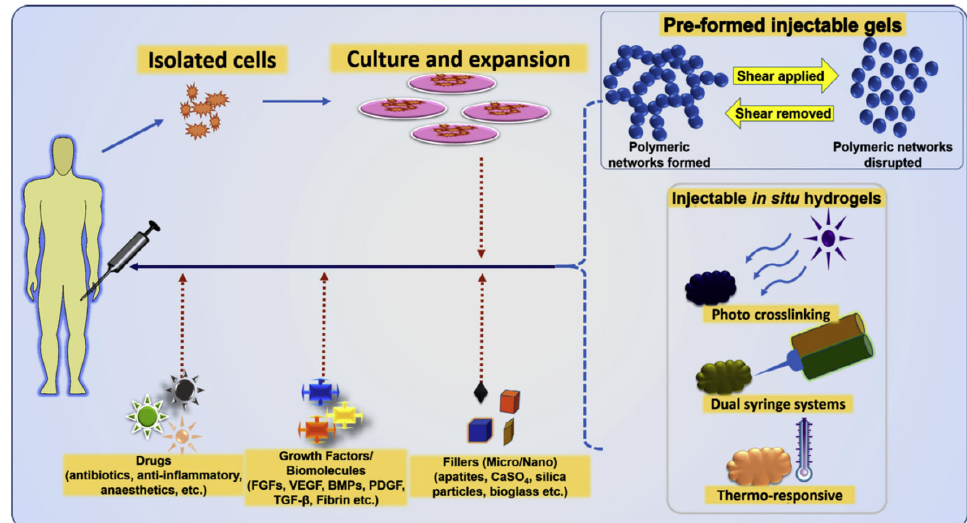
Figure 1. Schematic outlining pre ‐ formed injectable hydrogels along with different in situ ‐ formed hydrogels, and the possibilities of using them as carriers of cells, drugs, growth factor/biomolecules and fillers. Adapted with permission from [1]. Copyright 2015, Elsevier.